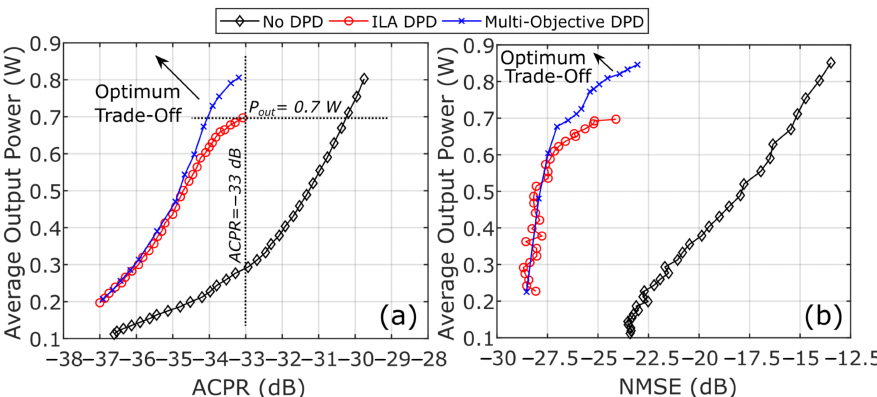
Figure 6. DPD performance when ¯ P OUT is maximized and the ACPR ( a ) or the NMSE ( b ) is a